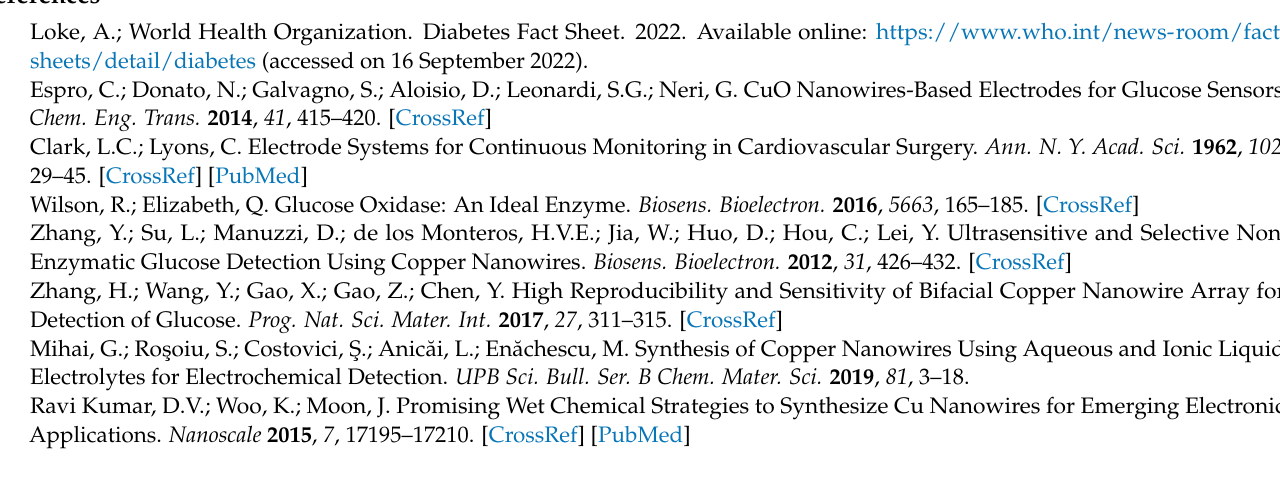
Figure S2: Images of electrodes after exposure to 50 mM alkaline environment: (a) Cu-NC on GC electrode; (b) Au-Cu-NC on GC electrode; Figure S3: (A) CV on Au-CuNC (red) and Cu strip electrodes (blue) at 50 mV/s in 5 mM [Fe(CN) 6 ] 3 − /4 − , 50 mM NaOH (inset Ipa vs. v 1/2 for both electrodes); (B) plot of Ψ vs. 32.8 V − 1/2 in 5 mM [Fe(CN) 6 ] 3 − /4 − , 50 mM NaOH. The factor 32.8 in the abscissa represents the quantity ( π DnF/(RT)] − 1/2 . The inset presents the plots of Ψ values vs. ∆ E p for both electrodes, Figure S4: Cyclic voltammogram of Au-CuNC (blue) and Cu strip (red) in the presence of 0.1 mM glucose in 50 mM NaOH solution at 5 mV/s scan rate, Figure S5: Cyclic voltammetry of 0.1 mM of glucose on Au-CuNC in different alkaline environments, 5 mM and 50 Mm NaOH solutions, Figure S6: 10th cycle of CV of Au-CuNC electrode in 50 mM NaOH at 5 mV/s (red) and Au-CuNC electrode after 10th cycle in the presence of 0.1 mM glucose in 50 mM NaOH at 5 mV/s (blue). Table S1: Electrochemical parameters of electroactive area (A eas ), roughness factor ( ρ ), heterogenous electron transfer constant (K 0 ), and the standard heterogeneous rate constant (Ks) for Au-CuNC and Cu strip electrodes in 5 mM [Fe(CN) 6 ] 3 − /4 − in 50 mM